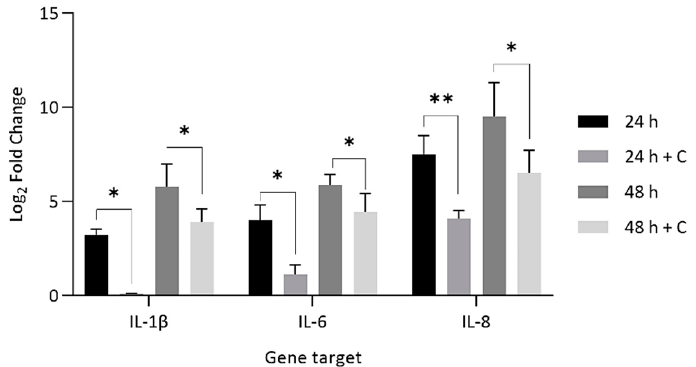
Figure 7. Comparison of log 2 fold gene expression changes for IL-1 β , IL-6 and IL-8 in NP-derived disc cells infected with C. acnes (MOI = 1:1000) versus cells pre-treated with clindamycin (+C) (0.25 µg/mL) for 60 min prior to C. acnes infection (MOI = 1:1000). * p < 0.05; ** p < 0.01.